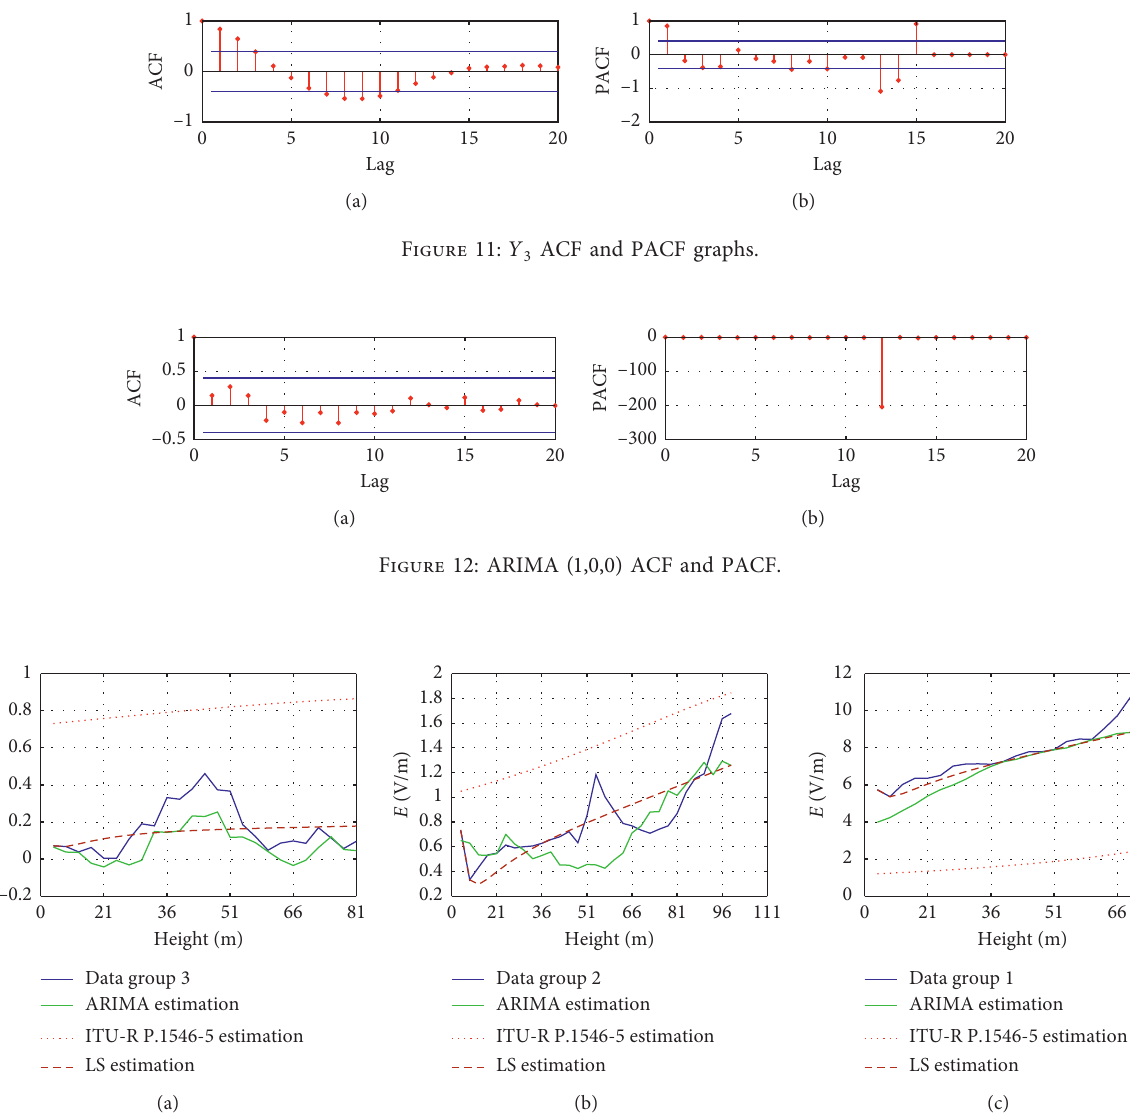
) , (b) “data2” with tendency reintegrated ( 􏽢 L 3